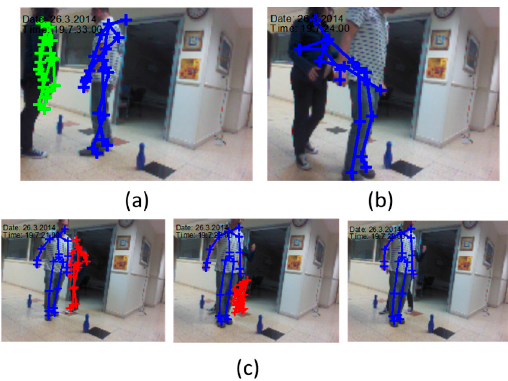
Figure 6. Artifact examples: ( a ) Skeleton out of proportions; ( b ) Skeleton wrong merge; ( c ) Skeleton distortion due to shadowing.